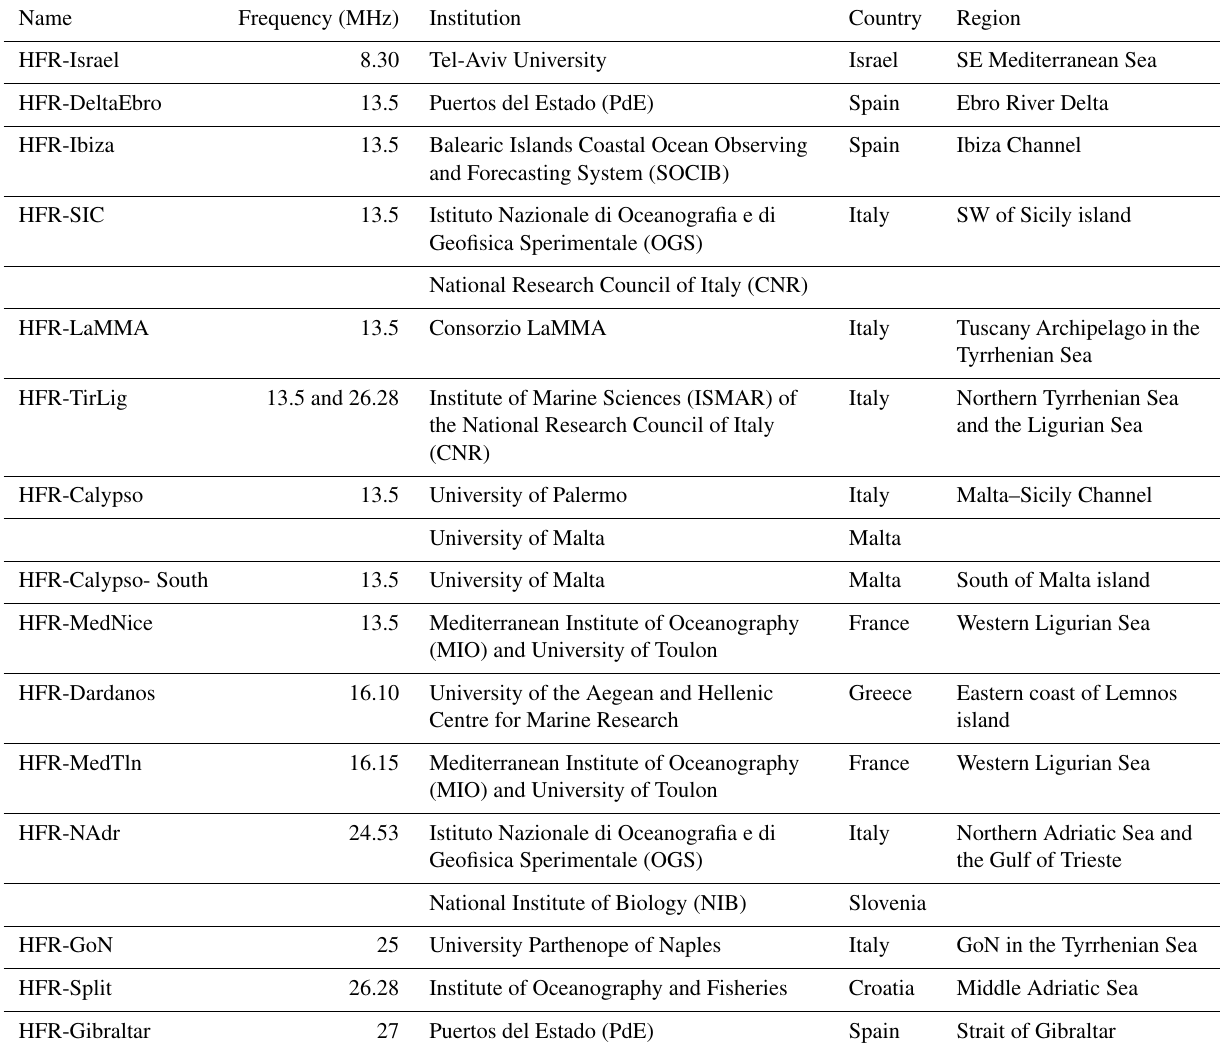
Table 2. Description of the HFR systems deployed in the Mediterranean Sea, which are currently working in an operational way. The list is ordered by frequency.